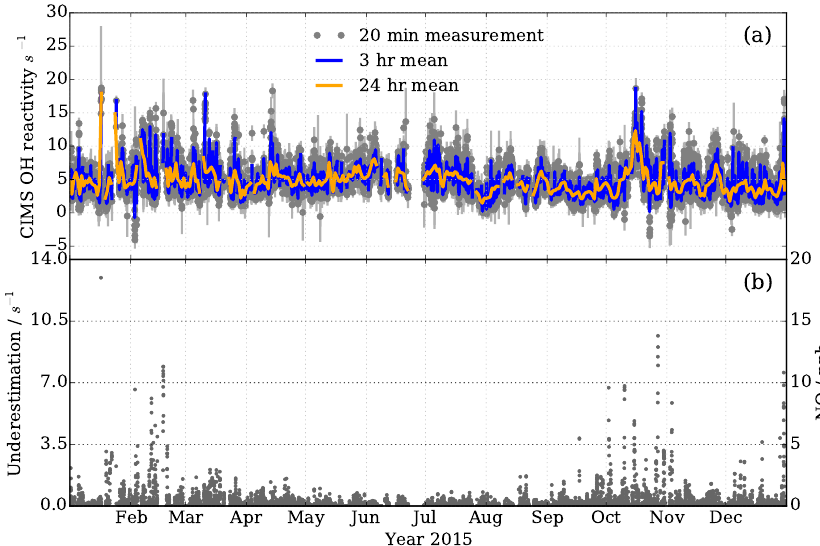
Figure 14. Observations at MOHp for the year 2015. (a) OH reactivity measurements by CIMS, with 3h and daily means in blue and orange, respectively. Filtered for recorded instrumental and laboratory interferences and seven outliers not coinciding with short term CO and NO 2 concentration peaks. 15541 valid measurement points. (b) Measured NO mixing ratios (right y scale) and estimated CIMS OH reactivity measurement underestimation as a result of NO presence in ambient air (left y